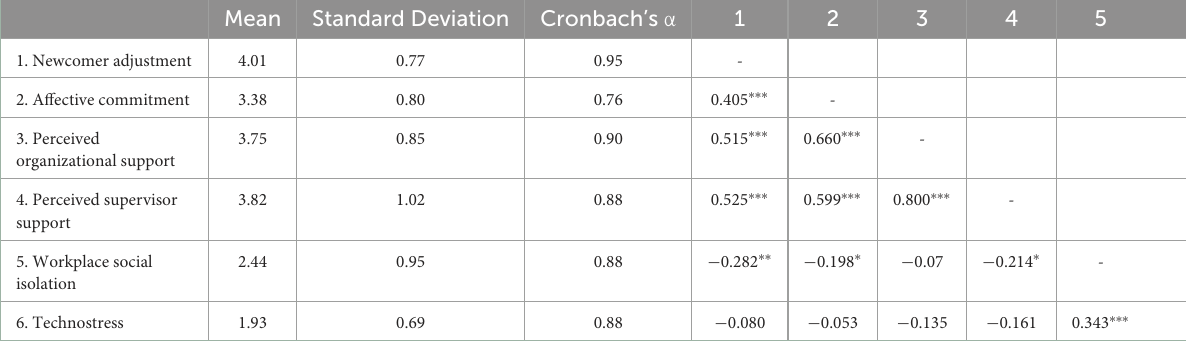
TABLE 2 Descriptive statistics and correlations of study variables.